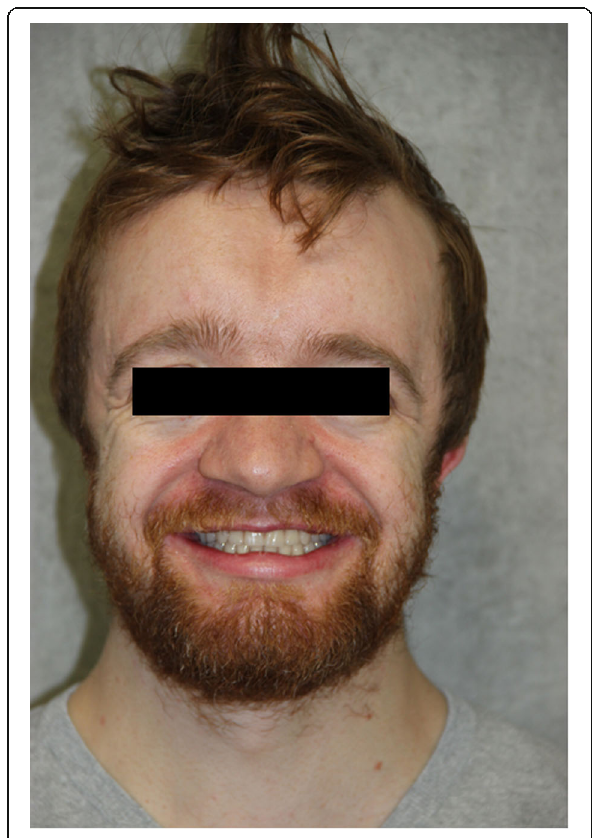
Fig. 7 Final frontal image after insertion of the fixed dental